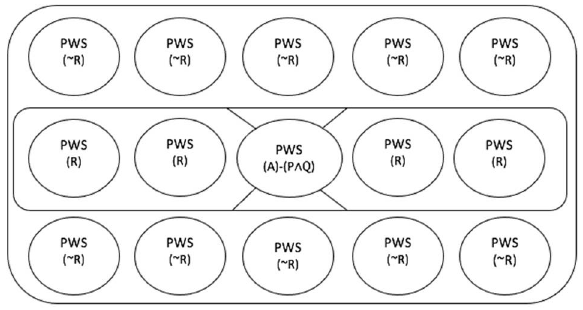
Figure 2. System of Possible World-States